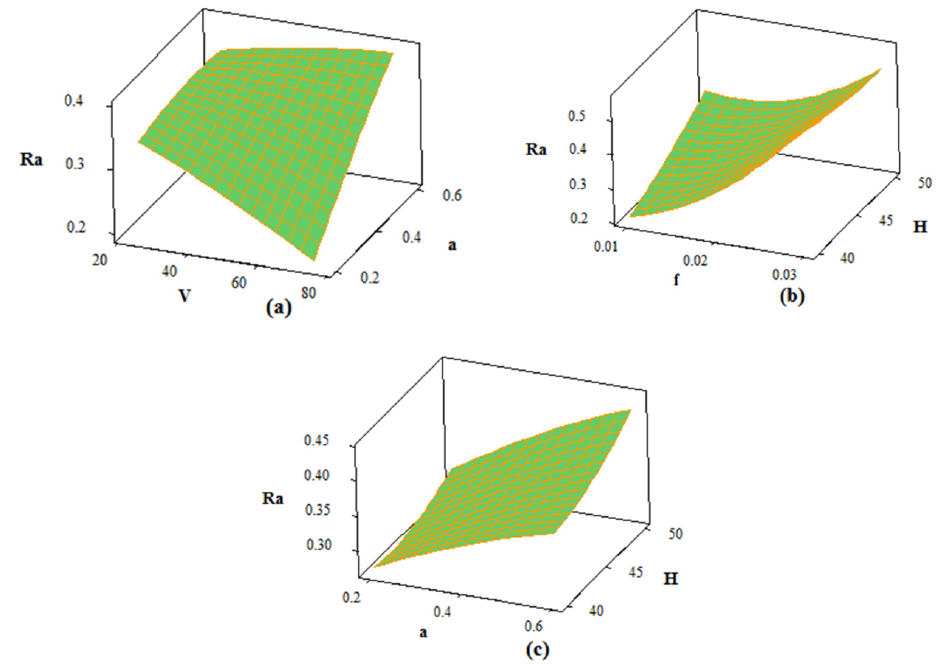
Figure 8. The response surface plot for Ra . ( a ) Feed rate of 0.02 mm/tooth, material hardness of 45 HRC, ( b ) cutting speed of 50 m/min, depth of cut of 0.4 mm, ( c ) cutting speed of 50 m/min, feed rate of 0.02 mm/tooth.